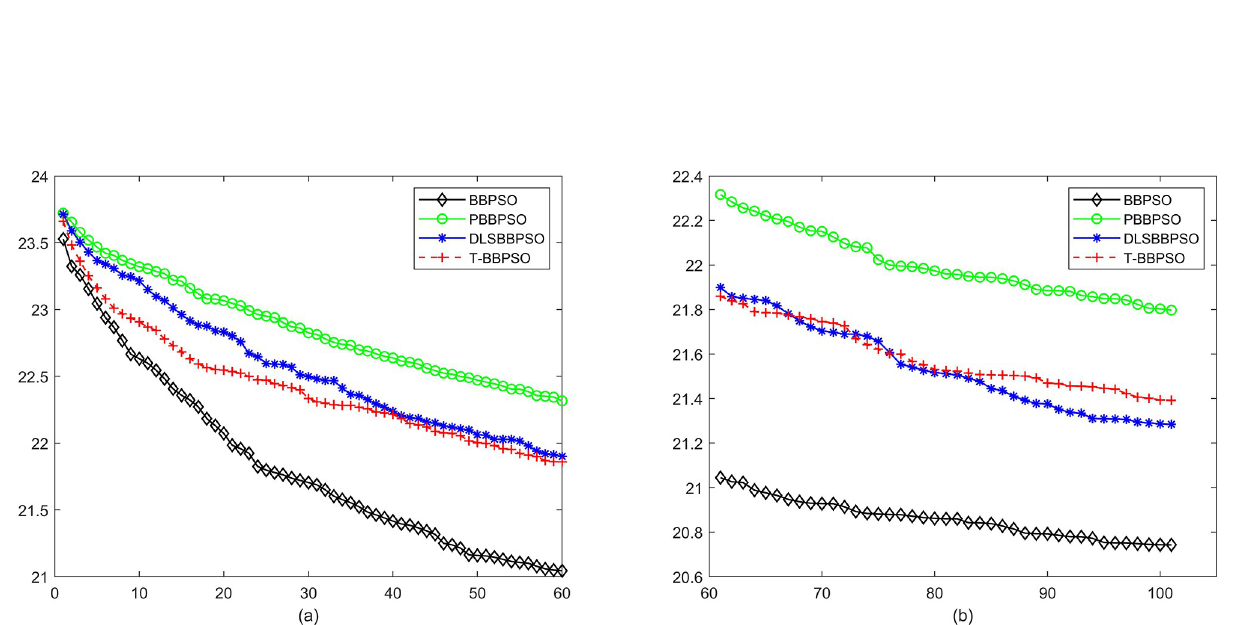
Fig 17. Comparison of convergence speed between BBPSO, PBBPSO, DLS-BBPSO and TBBPSO, f 15 , (a) iteration 0–6000, (b) iteration 6000–10000 the unit is 100 iteration.